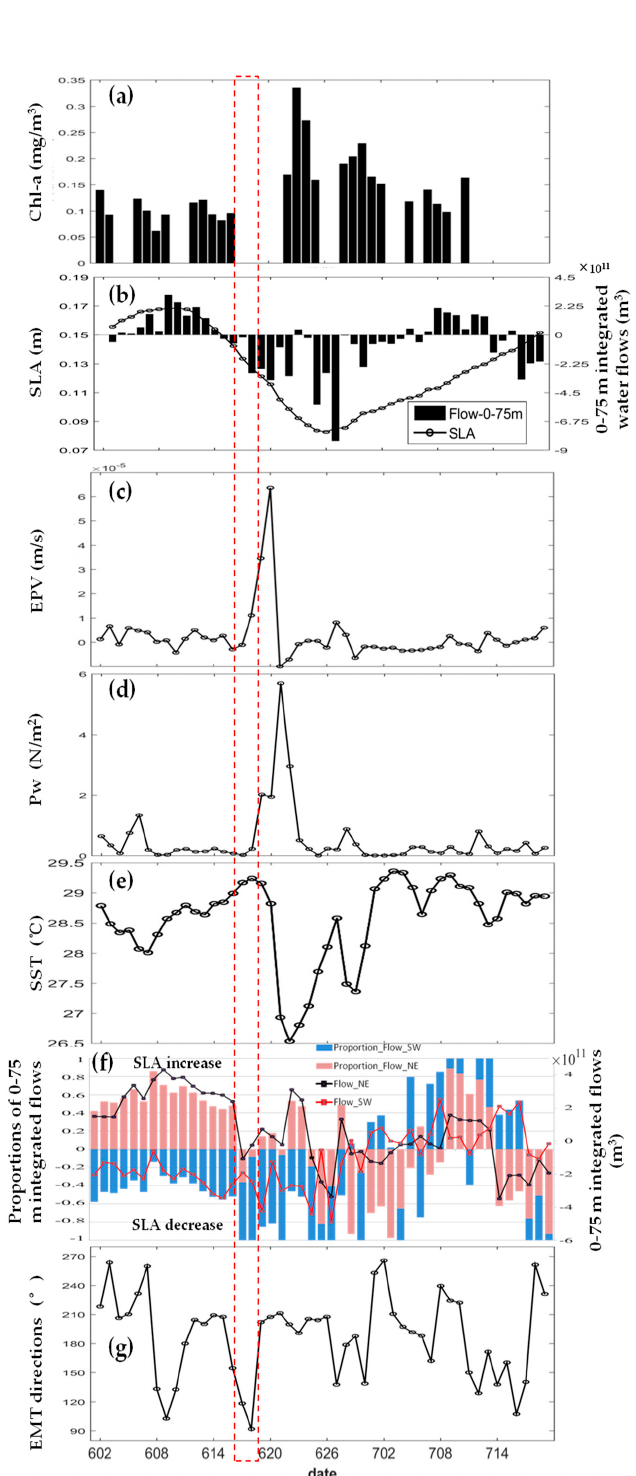
Figure 7. Time series of area average values about each factor within the study region before and after the typhoon. ( a ) Chl-a (mg / m 3 ); ( b ) SLA (m) and 0–75 m integrated water flows minus that of 2 June (m 3 ); ( c ) EPV (m / s); ( d ) P w (N / m 2 ); ( e ) SST ( ◦ C); ( f ) proportions and values of 0–75 m integrated water flows minus that of 2 June (m 3 , red and black lines represent the values of southwestward and northeastward water masses transport, respectively; the blue and red bars represent the proportions of southwestward and northeastward water masses transport, respectively; positive means inflows and divergence); red dash line box represents the period of typhoon passing the study